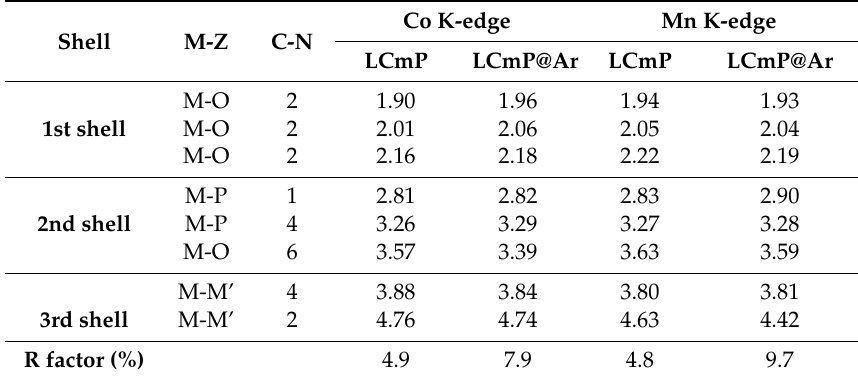
Table 5. Between scattering atoms in Å obtained by best fit for LCnP based samples. C-N is the coordination number. M-Z represents the central absorber (M, that is Co or Ni respectively in the Co K-edge and the Ni K-edge fits) and the scattering atom (Z, that is O, P / O or Co / Ni in the three shells considered). Statistical errors on distances are in all cases smaller than 0.01 Å. Shell